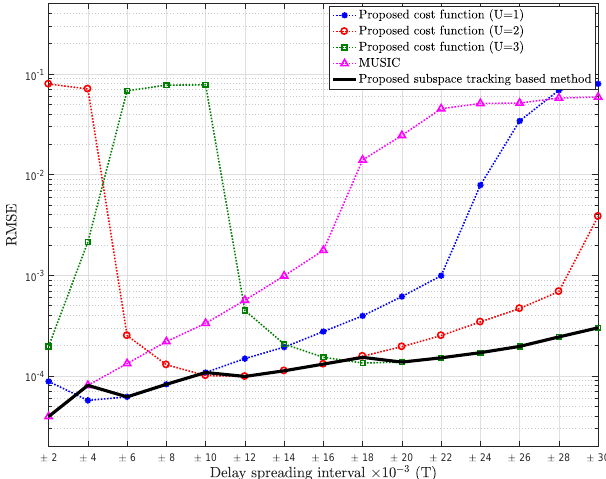
Figure 9. RMSE of mean delay estimation vs. delay spreading of the proposed cost function for U = 1, U = 2 and U = 3, the proposed subspace tracking based method, and MUSIC; L = 3, t = [ 0.37 0.51 0.67 ] T , P l = 20, K = 64, SNR = 15